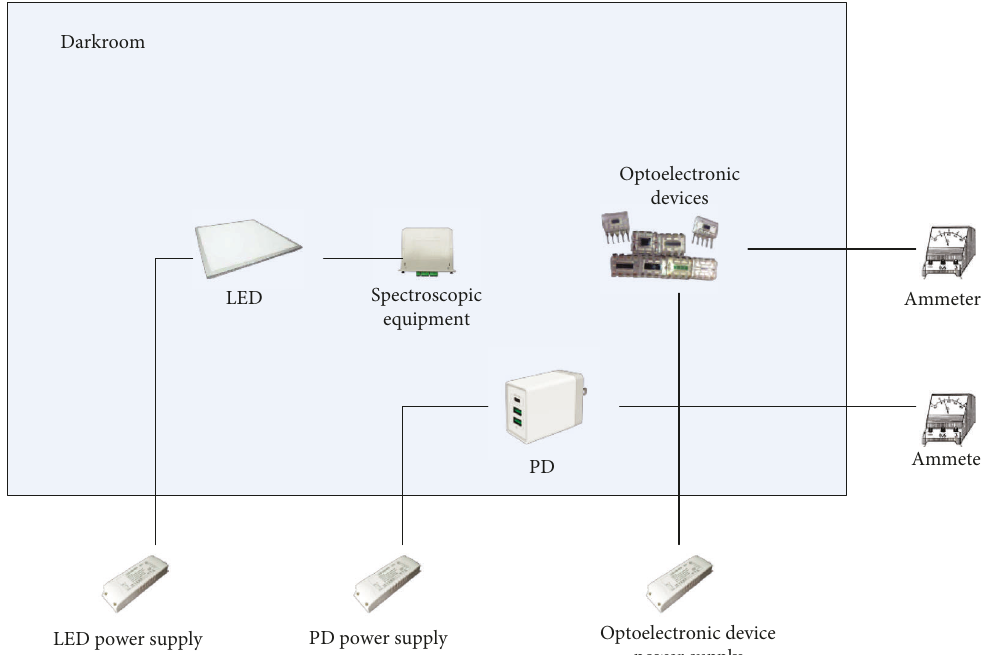
Figure 3: Schematic diagram of the quantum efficiency test of photoelectric